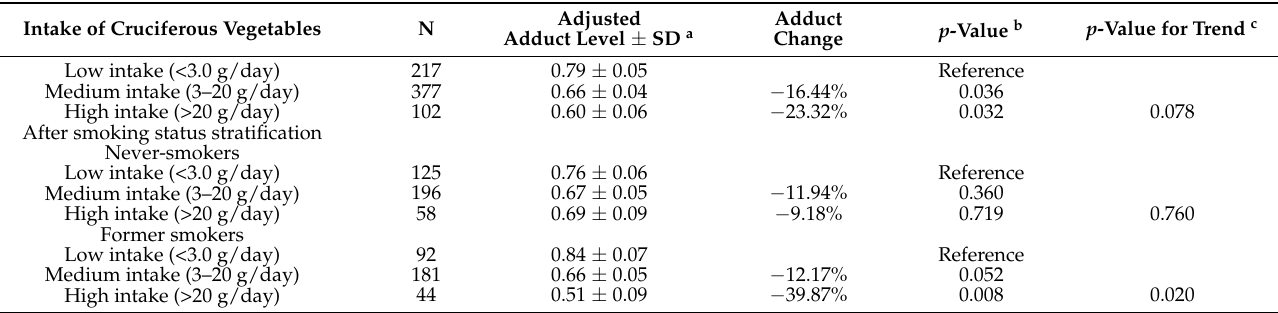
Table 3. Adjusted mean level of DNA damage by dietary cruciferous vegetable categories and smoking habits.